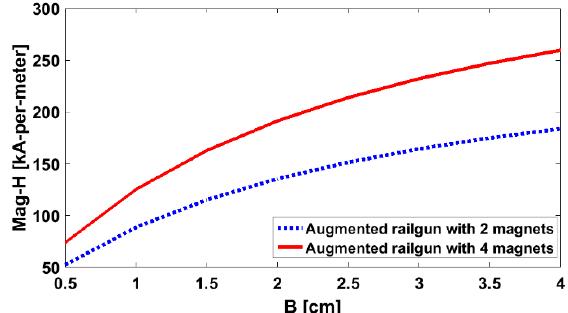
Figure 5: Magnetic field intensity versus the height (B) of permanent magnets: blue dashed line and red solid line are for the railgun structures of Figure 1 (a), (b),